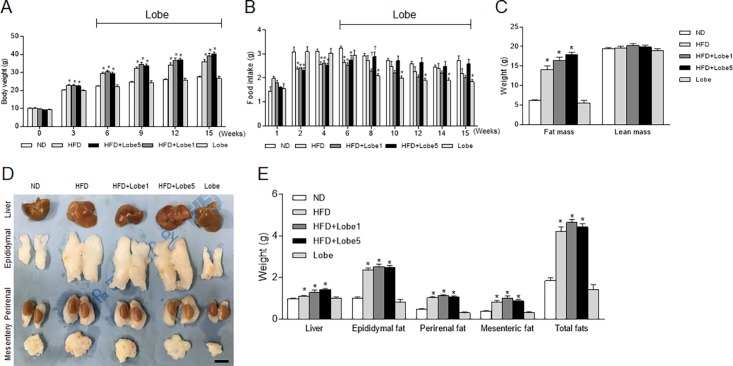
Effect of lobeglitazone (Lobe) on body weight and food intake in high-fat diet (HFD)-fed mice.Mice were fed Lobe (1 or 5 mg/kg/d) for 9 weeks (n = 8 per group). (A) Body weight, (B) food intake, (C) fat and lean mass, (D) representative photographs of intraabdominal organs, and (E) organ weights for each group at the time of sacrifice (18 weeks of age). Data are presented as mean ± SEM. *P <0.05 vs. normal diet (ND)-fed mice; †P <0.05 vs. HFD-fed mice. Scale bar = 1 cm.